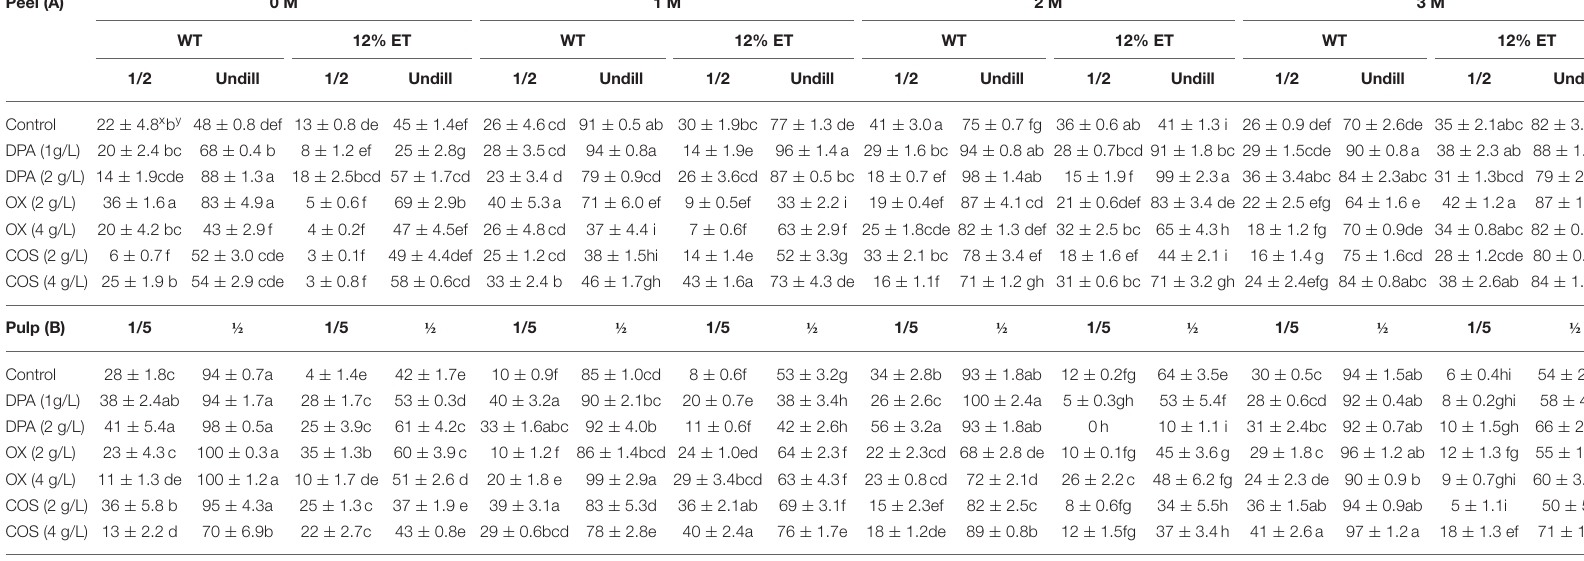
x ± Standard Error. y Different lowercase letters in each column represent significant differences in α -amylase enzyme inhibitory activity between extraction solvent × post-harvest treatment interactions separate for each dilution and each storage time point and for apple peel and